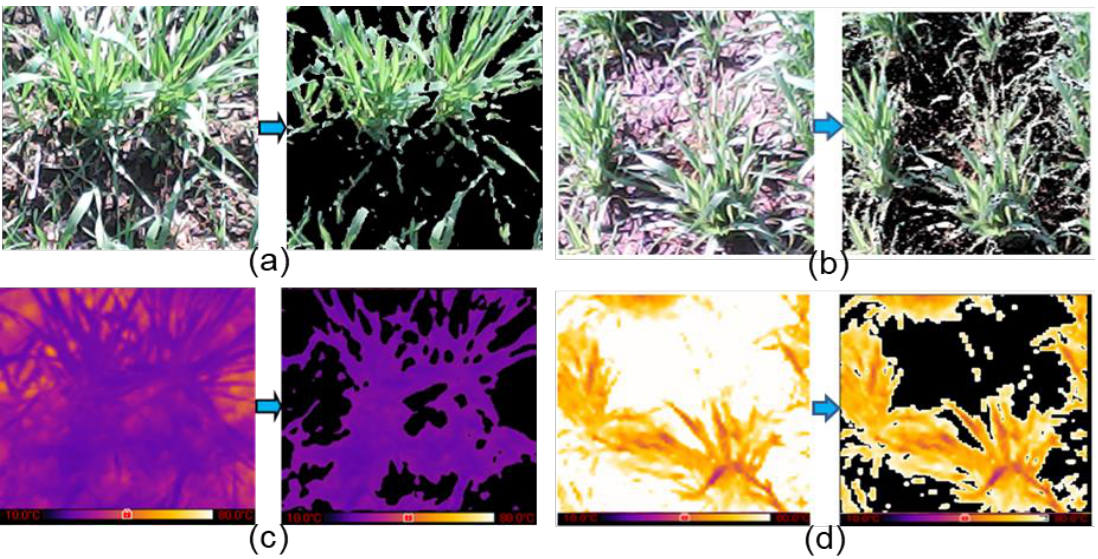
Figure 2. Sample raw and canopy masked RGB images (( a ) non-stressed; ( b ) stressed) and thermal images (( c ) non-stressed, ( d ) stressed) captured 35 days after sowing. Pseudo-color thermal images here are only for presentation and were scaled between 10 °C (RGB: [25, 25, 113]) and 80 °C (RGB: [235, 246, 255]).